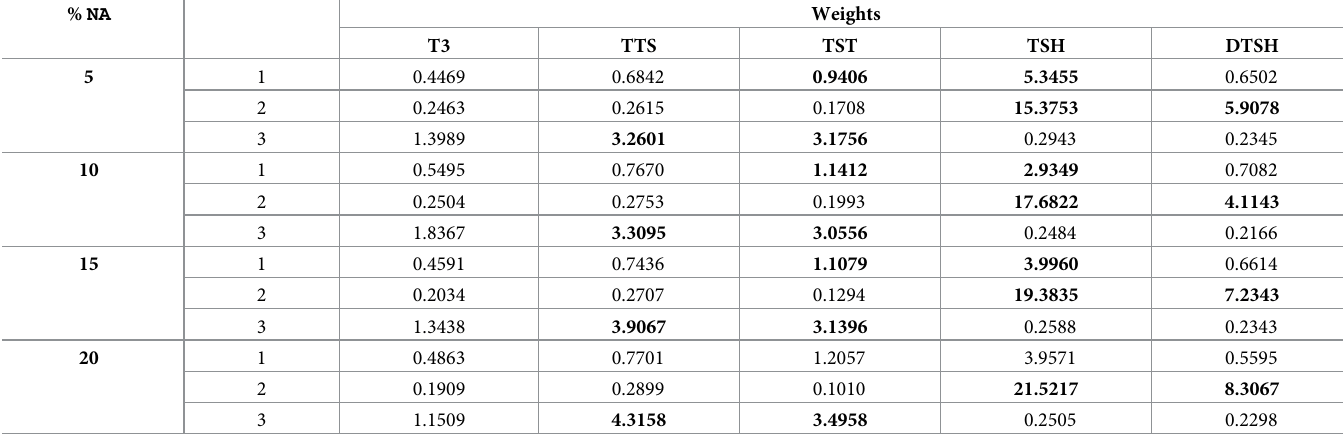
Fig 7. Average results of 100 repetitions for the error rate with Thyroid Gland dataset. https://doi.org/10.1371/journal.pone.0259266.g007 For the Imputation via Mean and Median values, missing values are filled using the mean or median estimates of the observed values in the datasets for each variable, before applying the clustering algorithm. For the Iris Plant dataset with 5% of missing values, accuracy was close to 0.90, which shows a good performance of the methods when imputing missing values. However, for the Thyroid Gland dataset, considering the same percentage of missing values, there are differ- ences in accuracy as shown in Fig 8a. This difference between the two datasets is expected, because the classes in the Thyroid Gland dataset are more overlapped than the classes in the Iris Plant dataset. In order to visualize and understand the data overlap, we applied Principal Component Analysis (PCA). Fig 9a and 9b show the resulting projections for the first two components. In PCA, the components are orthogonal and sorted according to how much vari- ance they explain, so it is possible to identify patterns and extract features [69]. Even after Table 9. Weights of the variables in each group found by the VKFCM-K-LP algorithm with the WDS strategy under different percentages of missing